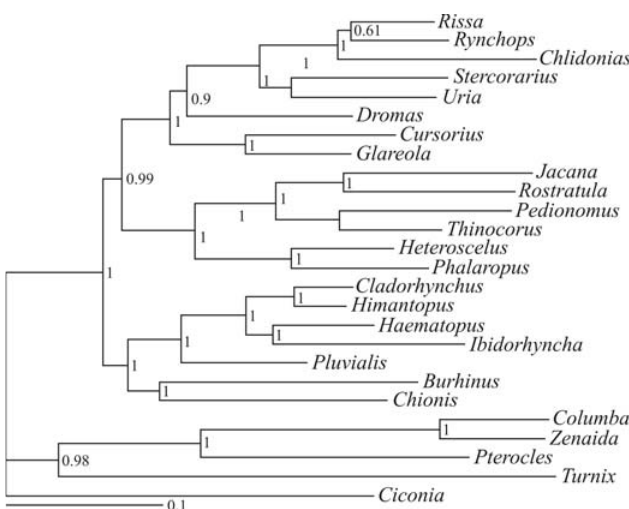
Figure S1 - Consensus Bayesian tree derived from the total evidence approach. Numbers at nodes are posterior